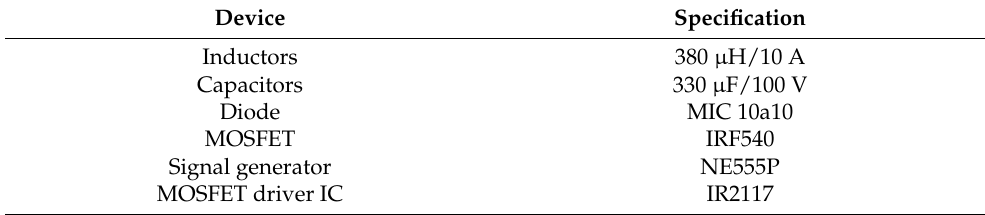
Table 5. Specification of experimental